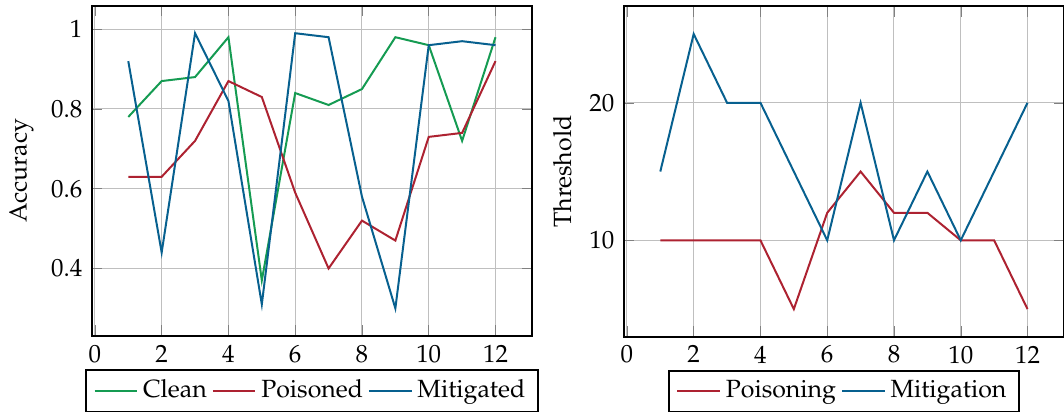
Figure 6. Dynamic New Entries Results.